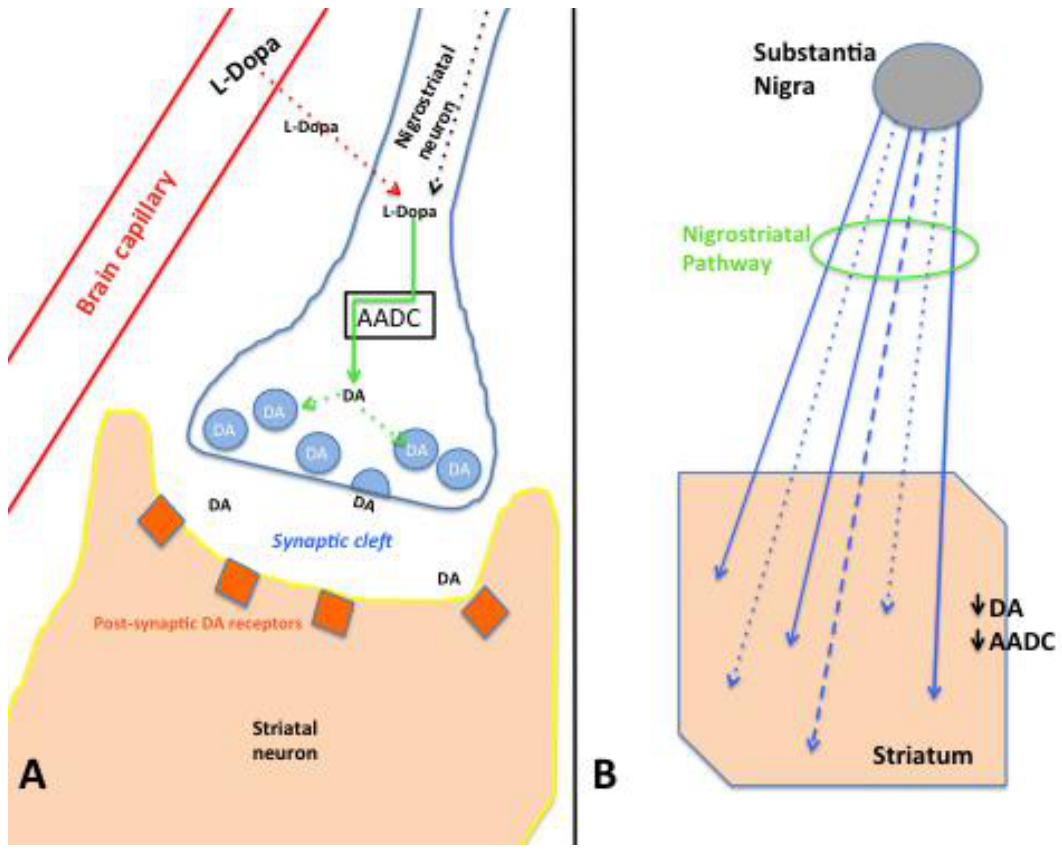
Figure 1. ( A ) Schematic representation of a brain dopaminergic perisynaptic region. A local capillary allows blood supply to deliver L -dopa to the brain parenchyma, traversing the blood-brain barrier and being taken up by the presynaptic dopaminergic nigrostriatal neuron (dotted red arrow). These neurons also produce L -dopa within the cell and transport it to the presynaptic terminals (dotted black arrow). At the neuron terminal, AADC (black box) converts L -dopa to dopamine (DA) (solid green arrow), allowing DA to be packaged (dotted green arrows) into presynaptic vesicles (light blue circles) for release into the synaptic cleft as part of neurotransmission. Released DA is able to interact with postsynaptic receptors on striatal neurons; ( B ) Schematic of the degeneration of the nigrostriatal pathway. Nigrostriatal dopaminergic neurons (blue arrows) originate primarily within the midbrain substantia nigra (dark gray oval) and extend into the striatum. With progressive degeneration of the nigrostriatal pathway (green circle), fibers lose their normal caliber and eventually lose function (dashed blue line) and degenerate (dotted blue lines), in association with loss of dopaminergic perikarya in the substantia nigra. Striatal biochemical assays show decreased DA and AADC levels associated with nigrostriatal